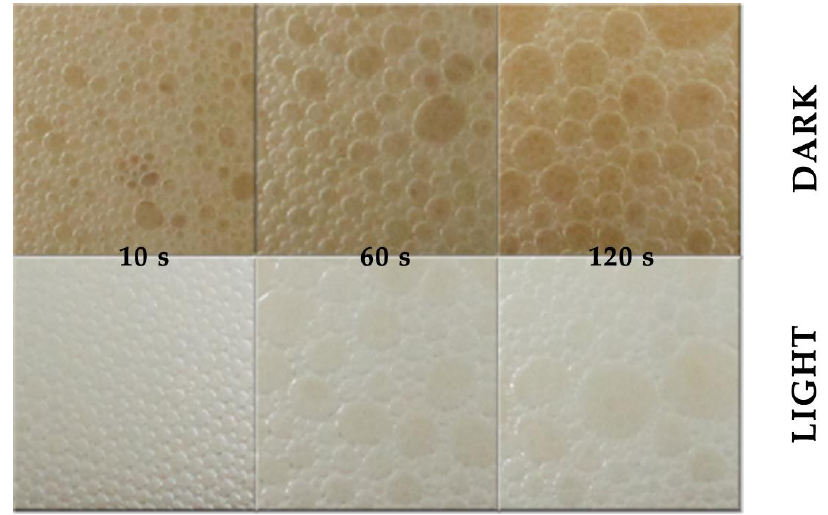
Figure 14. Different bubble size and distribution in the beer foam (10, 60 and 120 s after pouring). Figure 14. Di ff erent bubble size and distribution in the beer foam (10, 60 and 120 s after